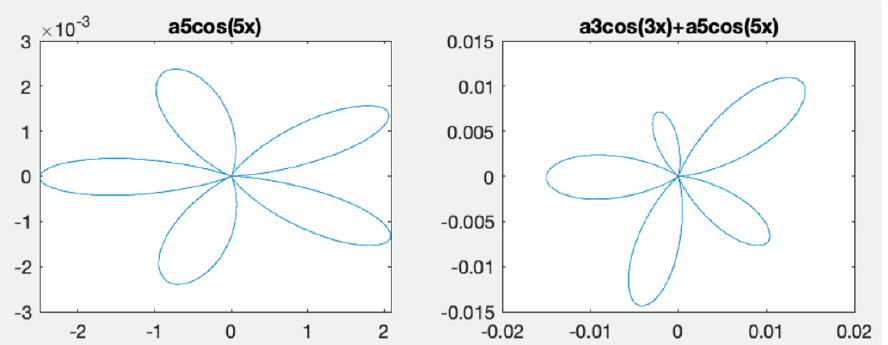
𝑐𝑜𝑠 (cid:4666) 5𝑥 (cid:4667) to the spin- 5